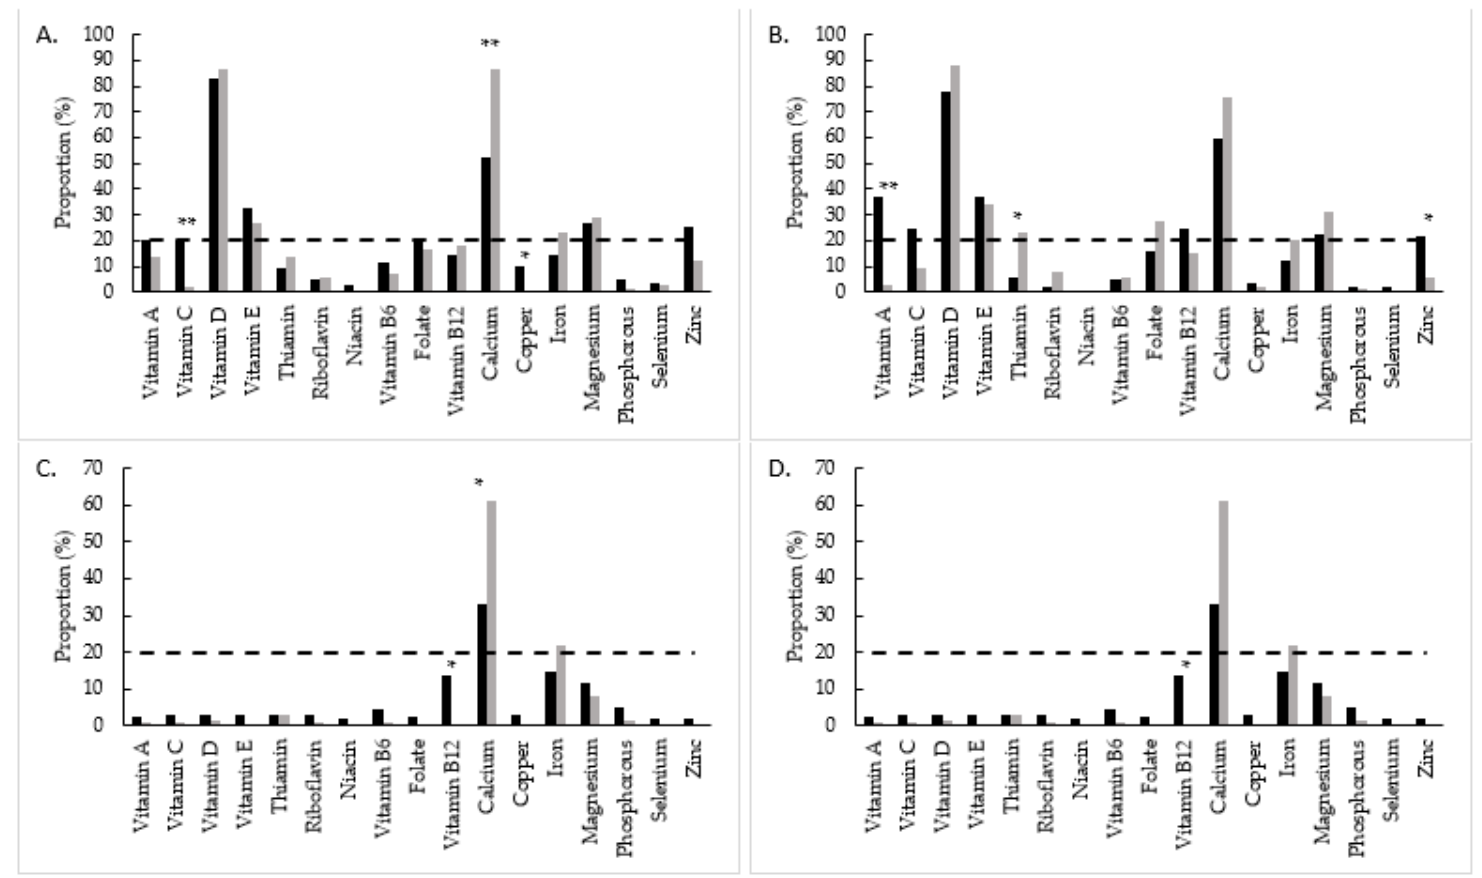
Figure 1. Proportion with inadequate micronutrient intake among the Swank (black bars) and Wahls (grey bars) groups from food at ( A ) 12 weeks and ( B ) 24 weeks and from food and supplements at ( C ) 12 weeks and ( D ) 24 weeks. The dashed line represents severe micronutrient inadequate intake defined as ≥ 20% of the group. Statistical significance determined by two sample z -tests; statistical significance is represented by * = p ≤ 0.05 and ** = p ≤